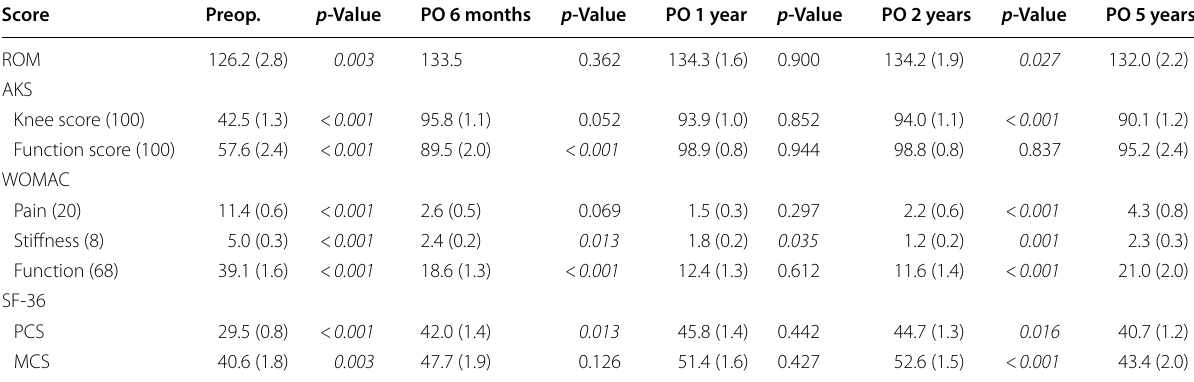
68 years with an MB implant ≥